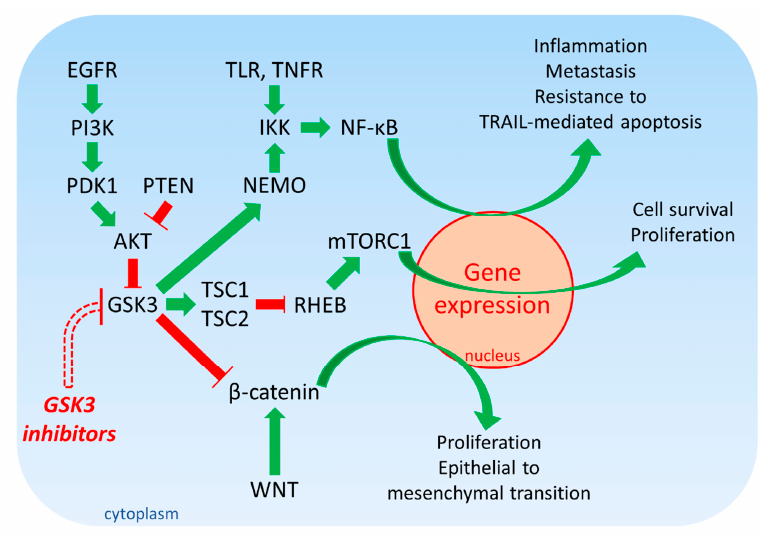
Figure 1. Overview of EGFR / PI3K / PDK1 / AKT / GSK-3 / mTORC1 Signaling. Green arrows indicate stimulation, blocked red arrows indicate inhibition.